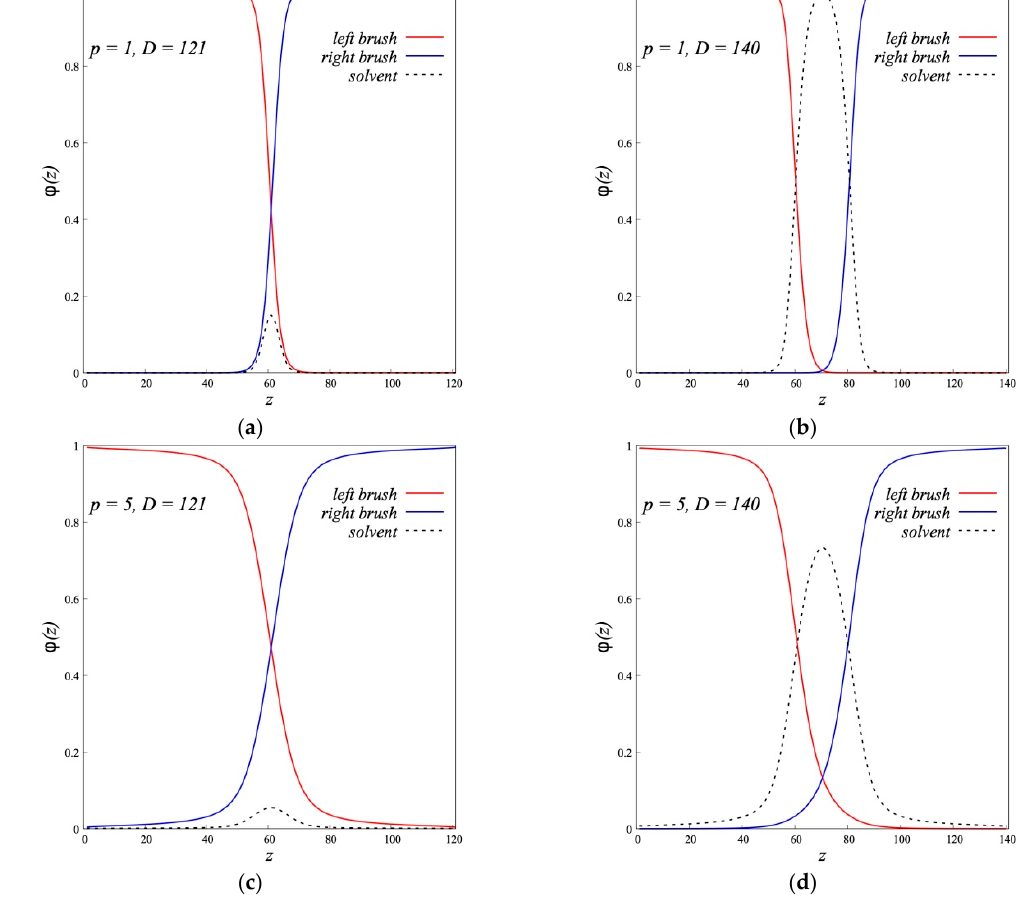
Figure 13. The volume fraction profiles of interacting dipolar ( τ = 5) polymer brushes consisting of flexible ( p = 1, D = 121 ( a ) and D = 140 ( b )) and rigid ( p = 5, D = 121 ( c ) and D = 140 ( d )) polymer chains ( N = 200, σ = 0.3).